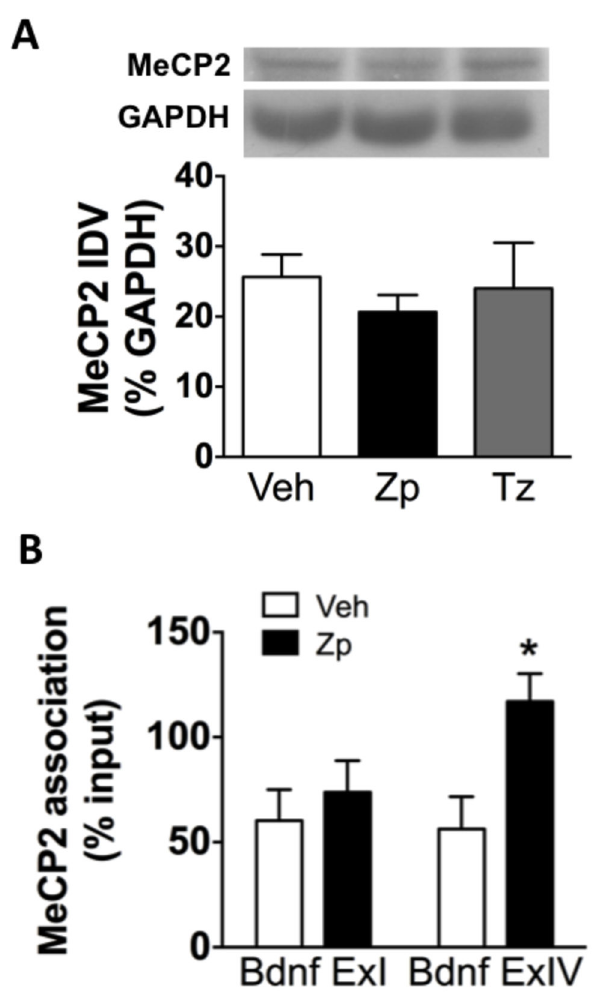
Figure 5. No change in histone acetylation in the HIP following acute BZ treatment. (A) There is no change in total AcH3 protein levels in the HIP following BZ treatment as measured by western blots (n= 3); (B) There is no change in AcH3 association with BDNF promoters in the HIP following ZP treatment as measured by ChIP (n= 4). IDV: integrated density